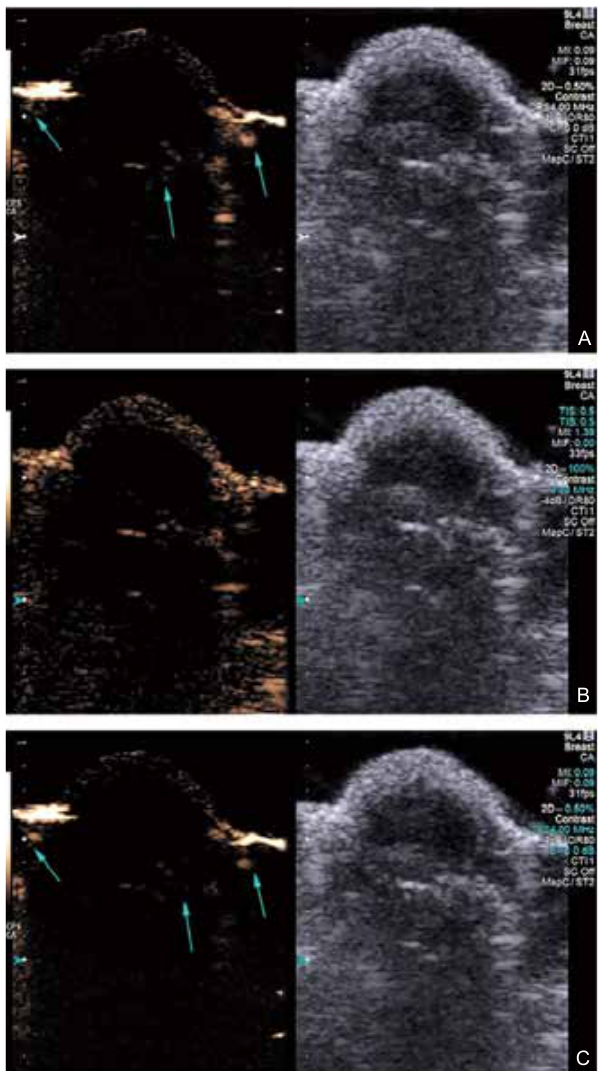
Figure 8 Examples of US imaging of O 2 MB + US + 10 Gy therapy to an MDA-MB-231 metastatic brain tumor within the murine skull. In all panels, the image on the right is the anatomic B-mode grayscale image, whereas the image on the left is the contrast mode image optimized to visualize the MBs within the tumor. (A) Microbubbles were visualized along the periphery of the tumor on injection, as denoted by arrows. (B) Destructive pulse to induce MB cavitation. (C) Reperfusion of MBs after destructive pulses, with MB visualization shown with arrows. (Reprinted with permission from reference [107]).